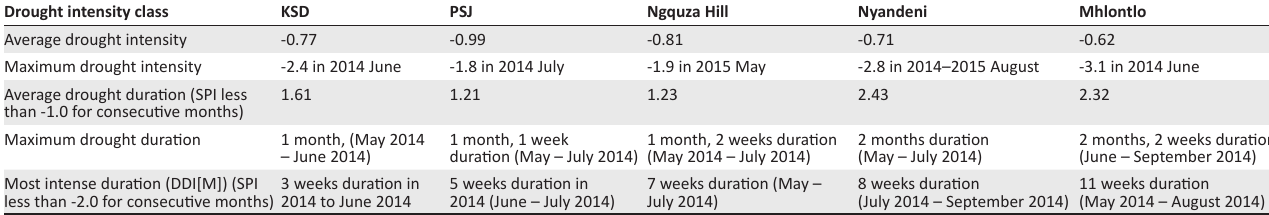
TABLE 5 : Drought intensity class for OR Tambo District Municipality during 1998–2018. Drought intensity class